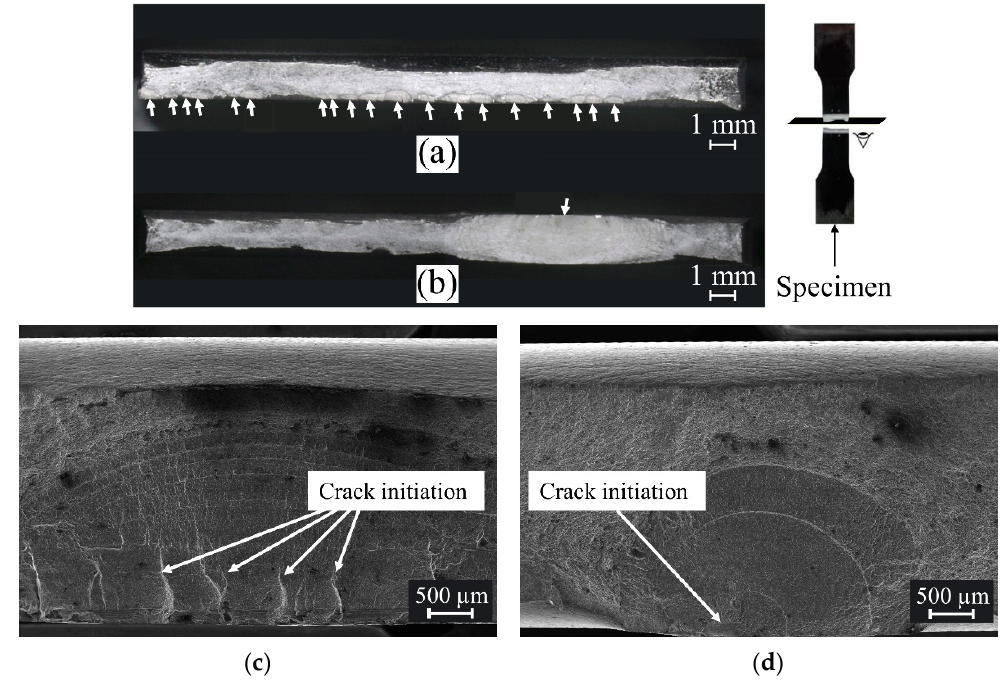
Figure 11. Light micrograph of the fracture surface of the ( a ) conventional and ( b ) stationary shoulder FSW specimens and SEM image of the crack initiation sites in ( c ) conventional and ( d ) stationary shoulder FSW specimens.